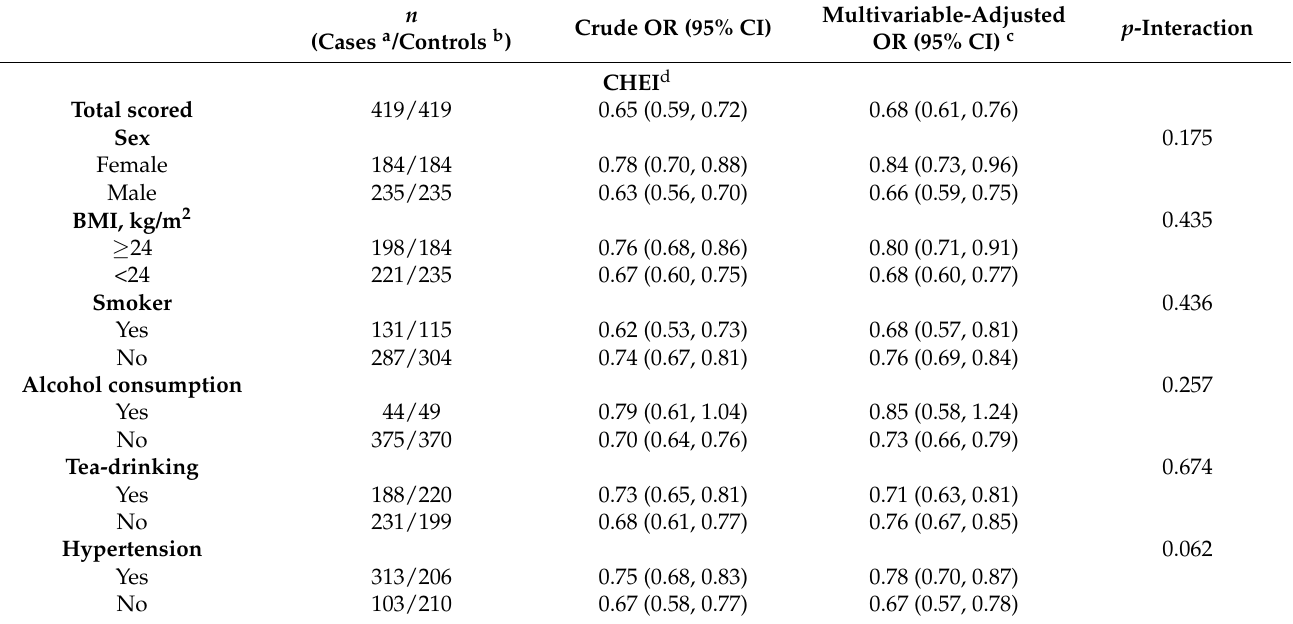
Table 3. ORs (95% CIs) of CVD for per 5-point increments in CHEI and HEI-2015 stratified by selected